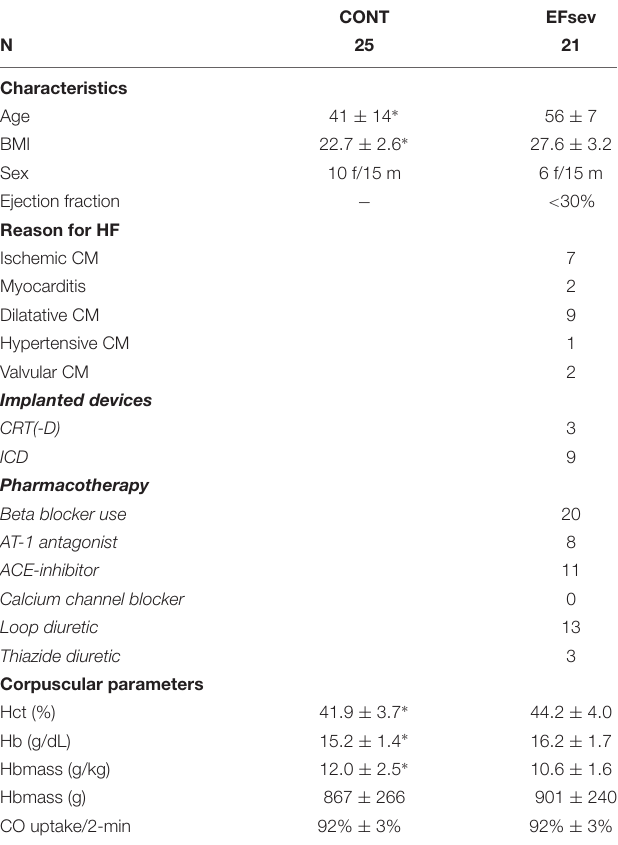
TABLE 1 | Subject